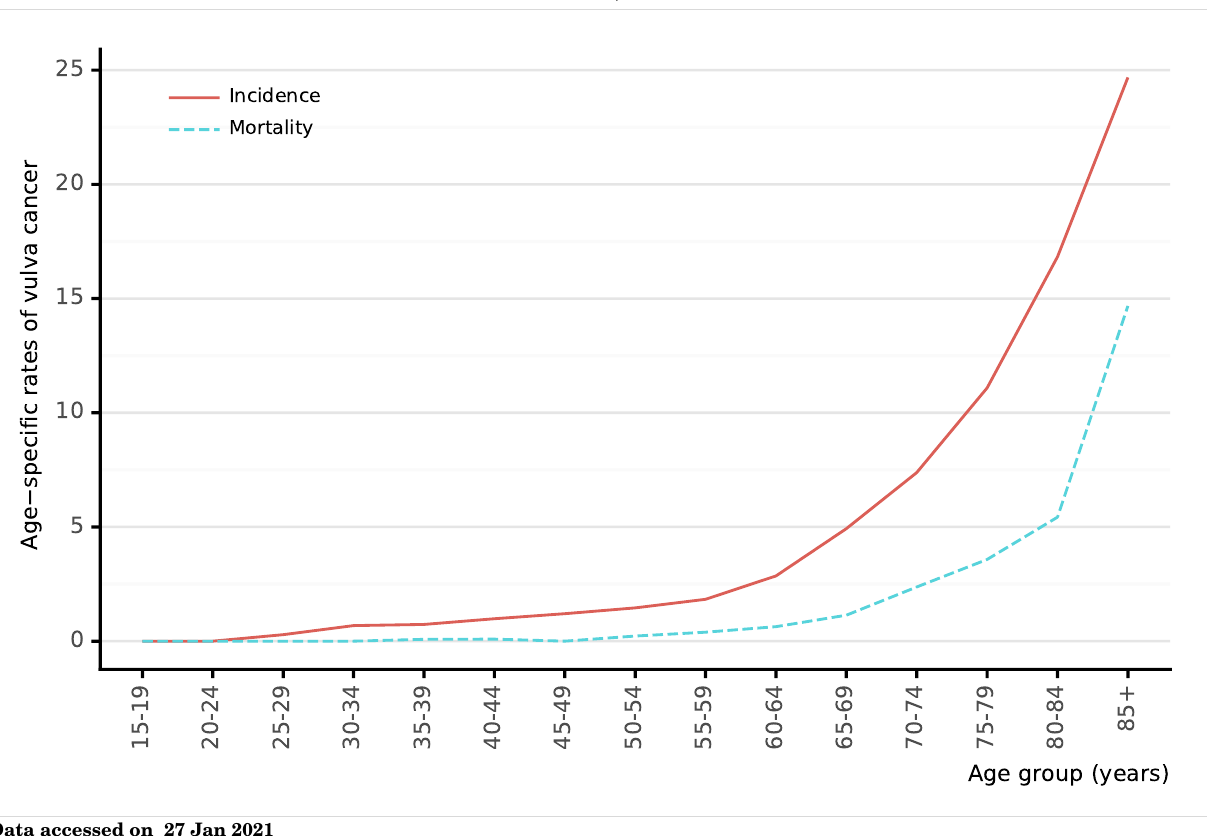
Figure 25: Comparison of age-specific vulva cancer incidence and mortality rates in Peru (estimates